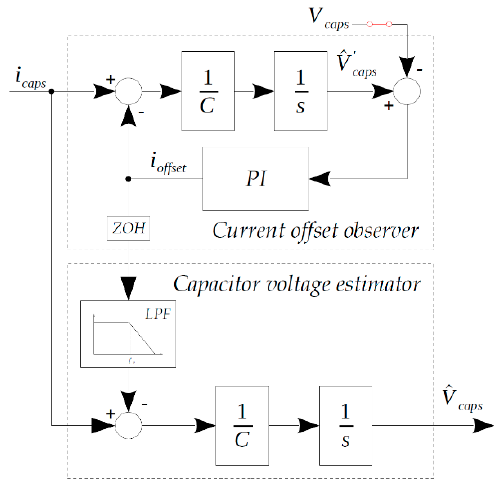
Figure 4. Capacitor voltage eRTS diagram.